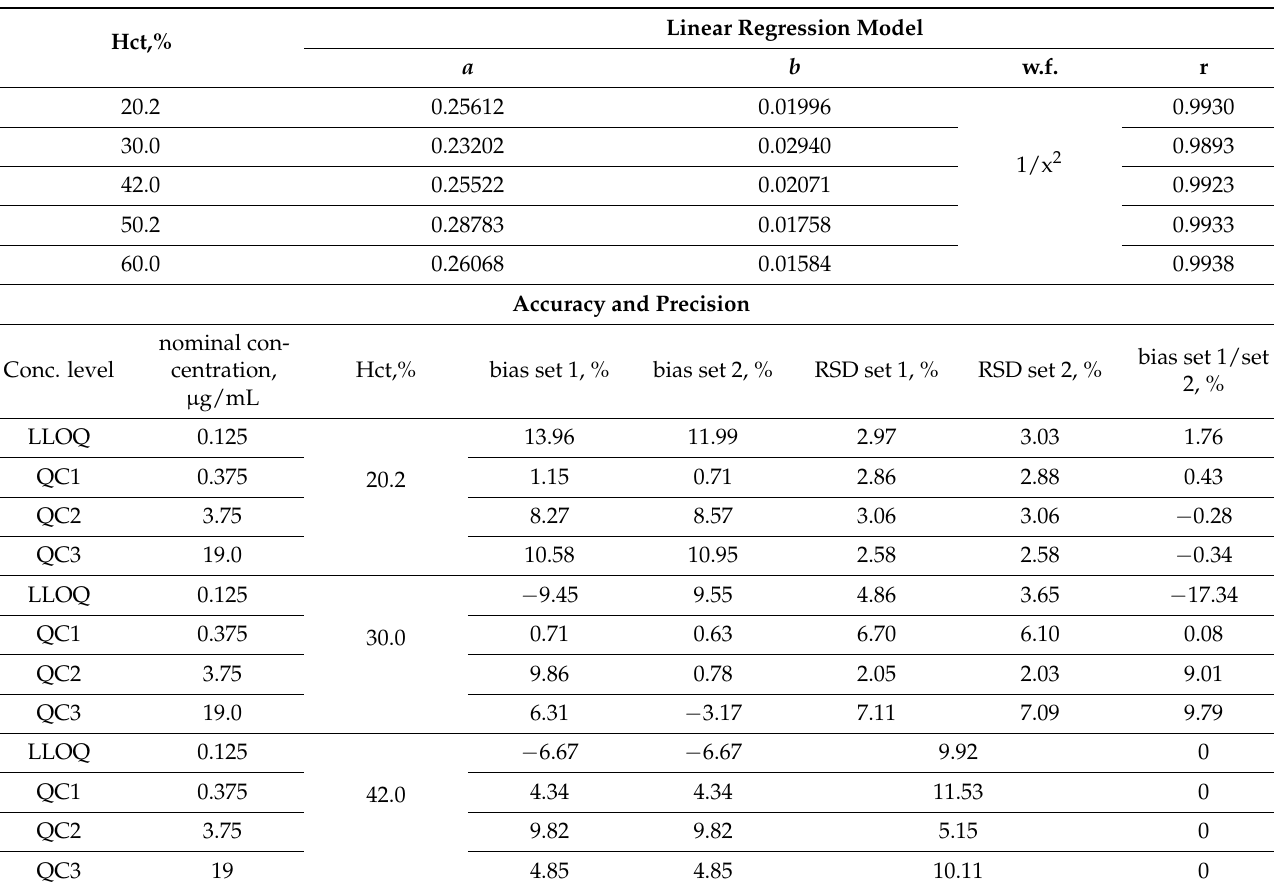
Table 6. Effects of Hct on the reliability (accuracy and precision) of the ZNS quantification in DBS. Linear Regression Hct,%